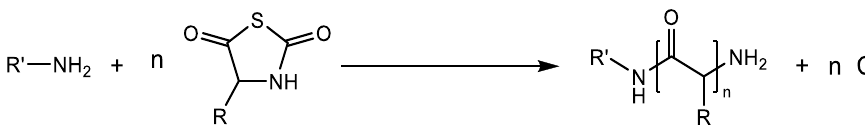
Figure 5. Synthesis of polypeptides via ring-opening polymerization of NTA.